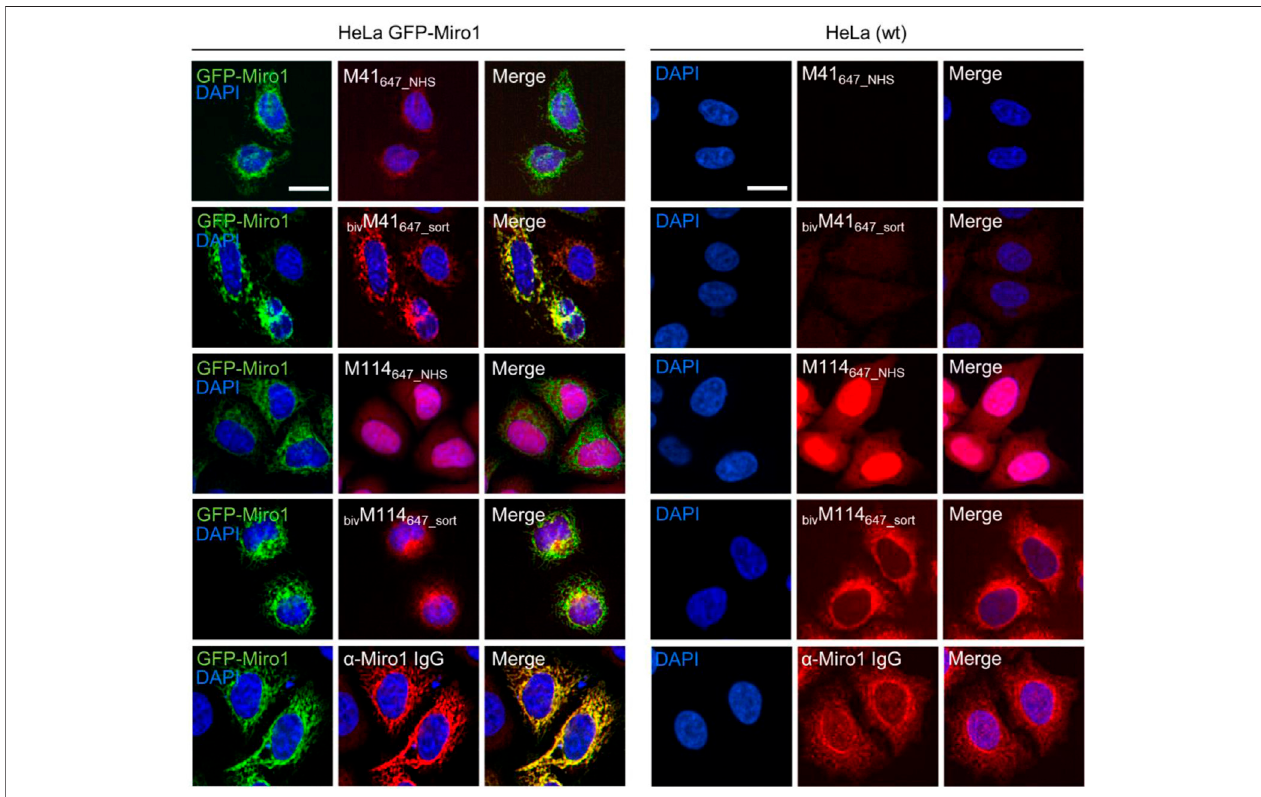
FIGURE 4 | Comparison of monovalent and site speci fi cally conjugated bivalent M41- and M114-Nbs in immuno fl uorescence. For comparable IF analysis HeLa cells transiently expressing GFP-Miro1 (left panel) or wildtype (wt) HeLa cells (right panel) were fi xed and stained with the mono- or bivalent Nbs conjugated either chemically(M41 647_NHS ,M114 647_NHS )orsite-speci fi cally via sortagging( biv M41 647_sort , biv M114 647_sort )toAlexaFluor647(647).Aspositivecontrolrespectivecellswere stained with an anti-Miro1 IgG followed by detection with a secondary antibody conjugated to AlexaFluor 647 (bottom row). Representative fl uorescence images are shown from three independent biological replicates. Nuclei were counterstained with DAPI. Scale bar 20